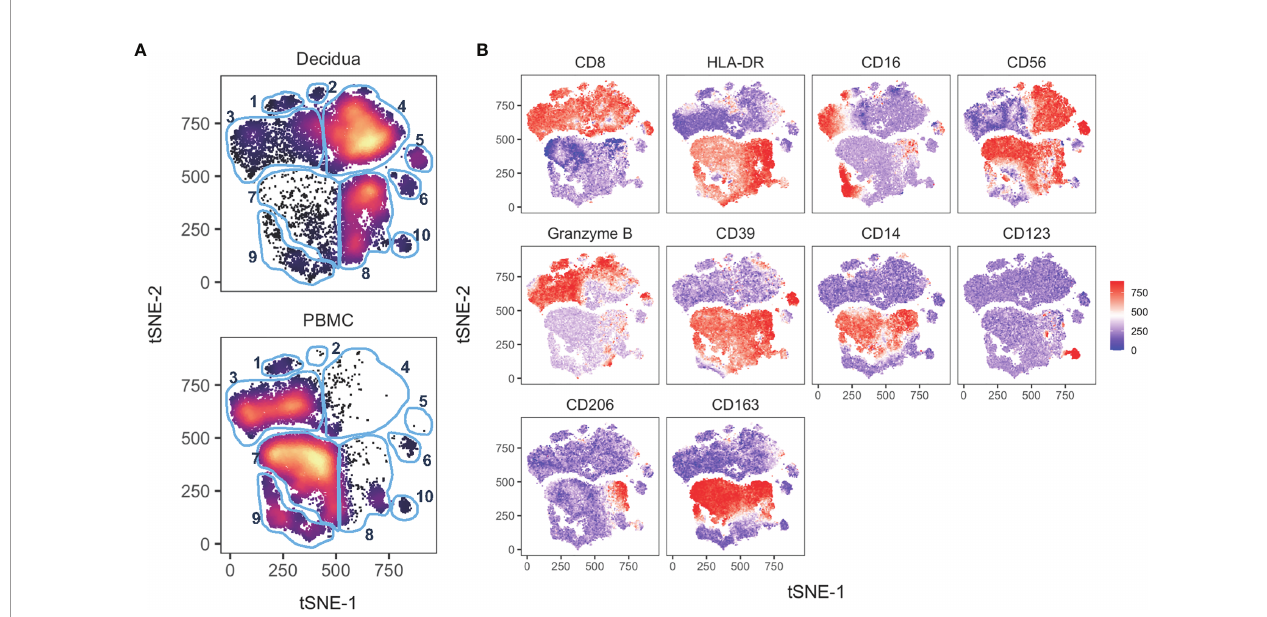
FIGURE 7 | tSNE of 14 innate cell markers of PBMC and decidual leukocytes in normal pregnant rhesus macaques. (A) tSNE plot representing an equal number of CD45+/live/single cells/CD3-CD20- cells from decidua (n = 8) and PBMC (n = 11) of rhesus macaques experiencing a normal pregnancy. The 18-color innate panel was used to generate this plot. Blue gates were manually drawn based on clustering patterns. (B) Individual MFI gradients of ten markers on the tSNE map. Red coloring represents high MFI and blue coloring represents low MFI. Remaining gradients are found in Supplemental Figure 4